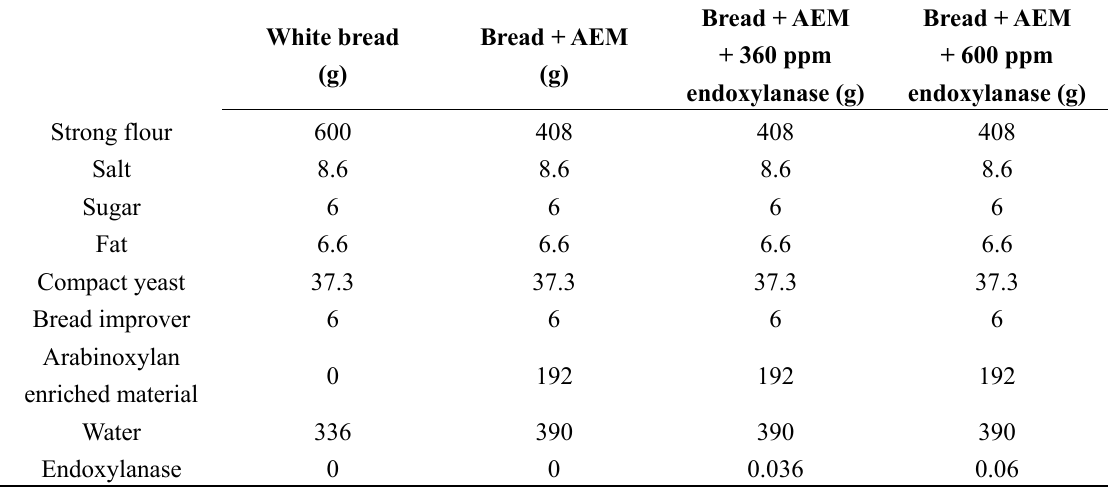
Table 1 . Bread recipe. AEM, arabinoxylan (AX)-enriched